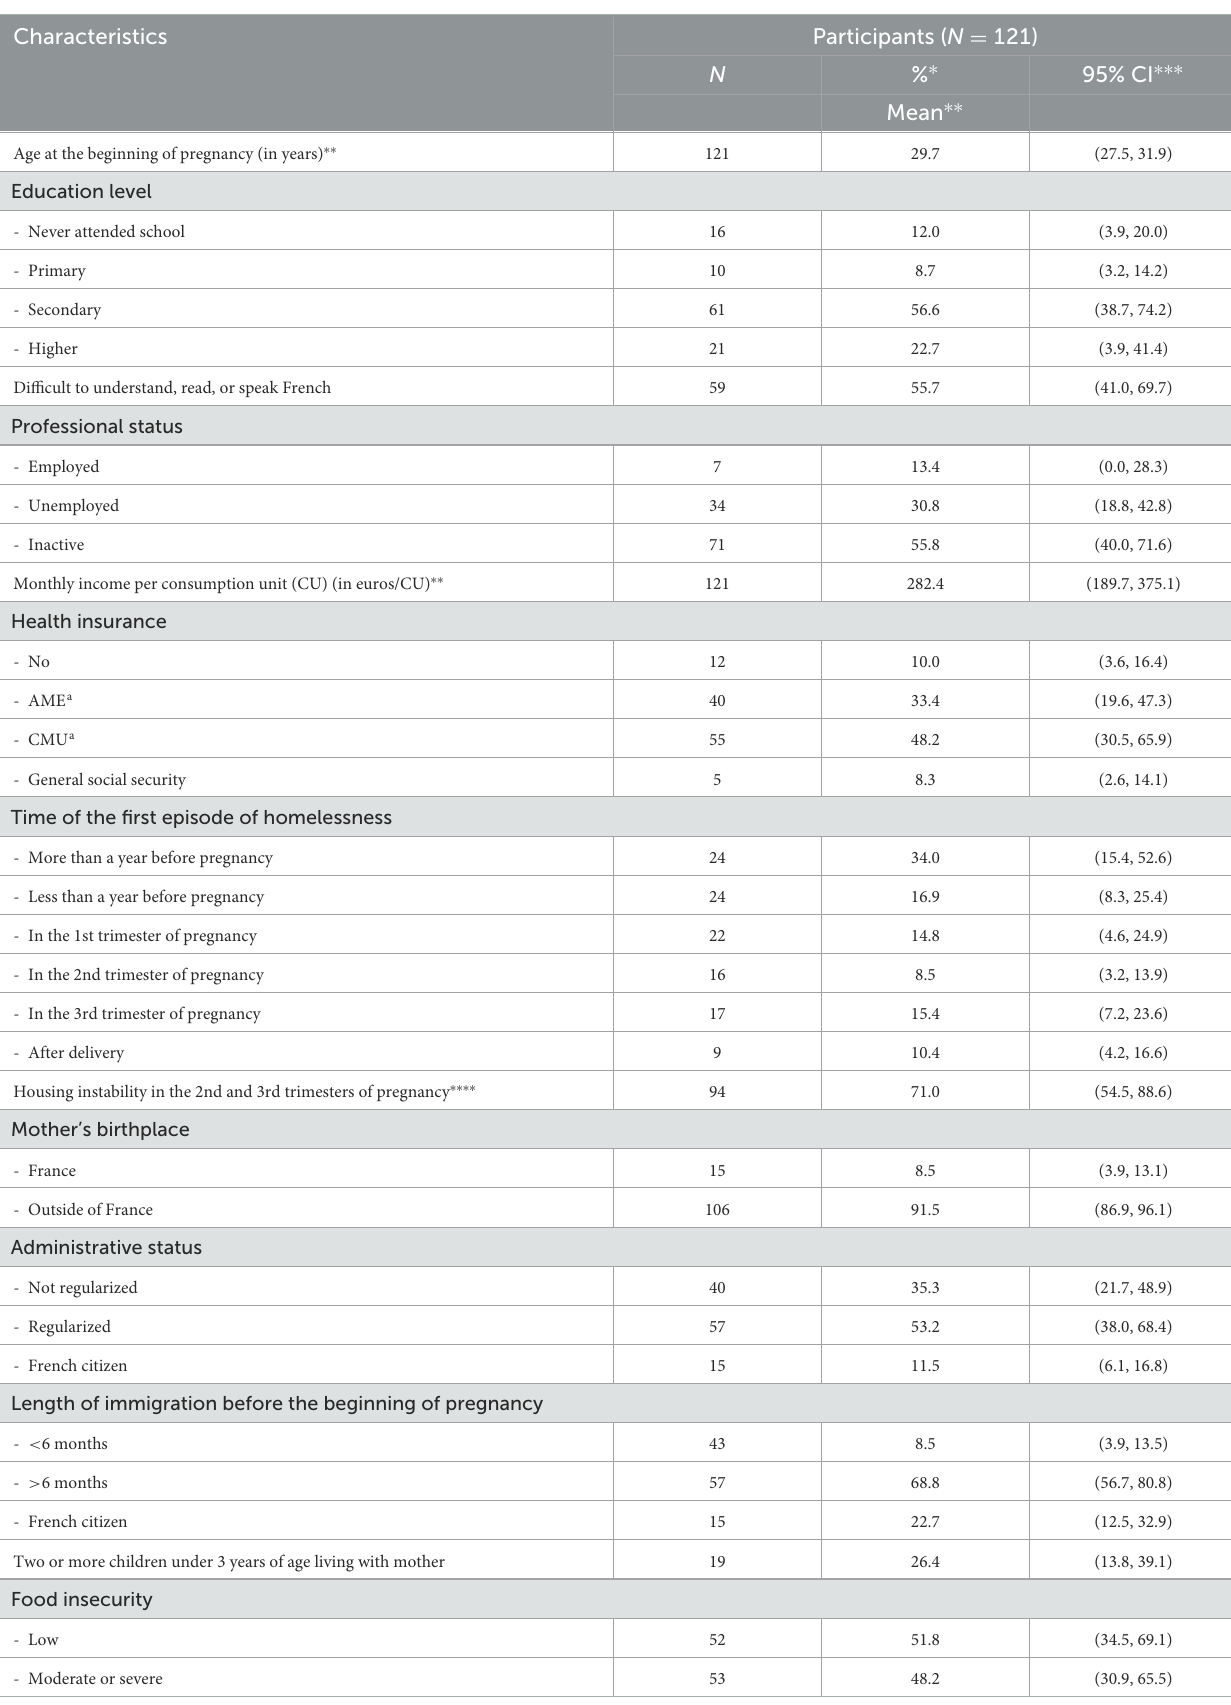
TABLE 2 Characteristics of sheltered homeless mothers with at least one child under 1 year old ( N = 121). ENFAMS cross-sectional survey, Greater Paris area, 2013.